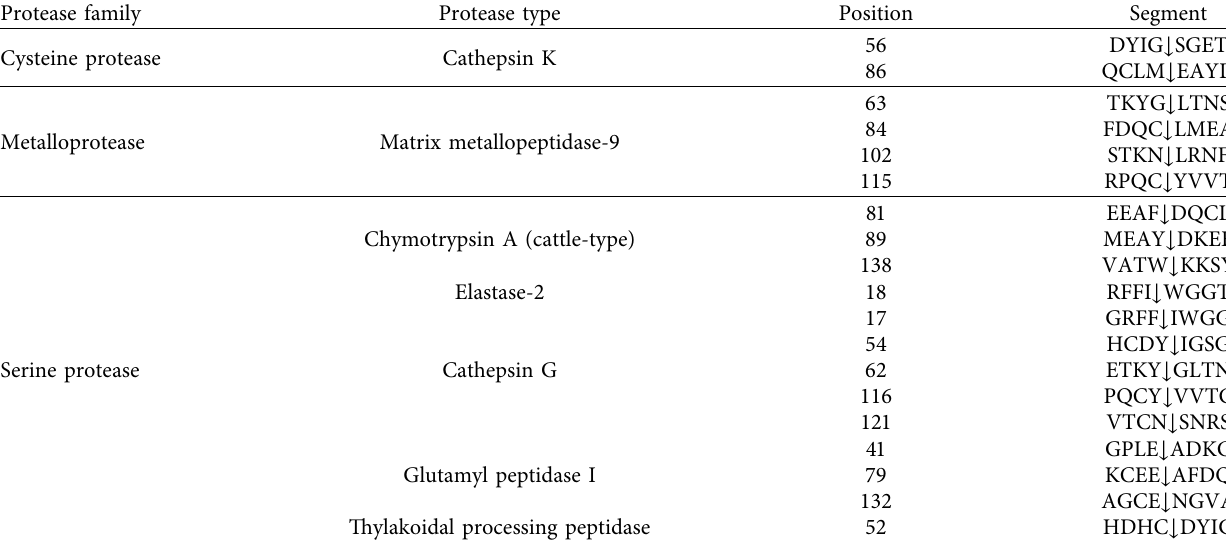
Table 3: Predicted cleavage sites of individual proteases. Restriction sites have been shown by ( ↓ ). Protease